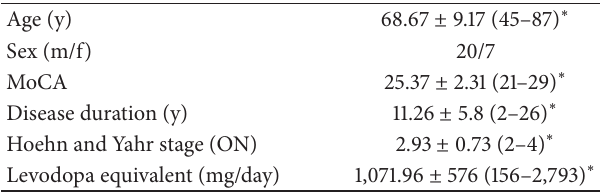
Table 1: Clinical characteristics of PD patients ( 𝑛 =